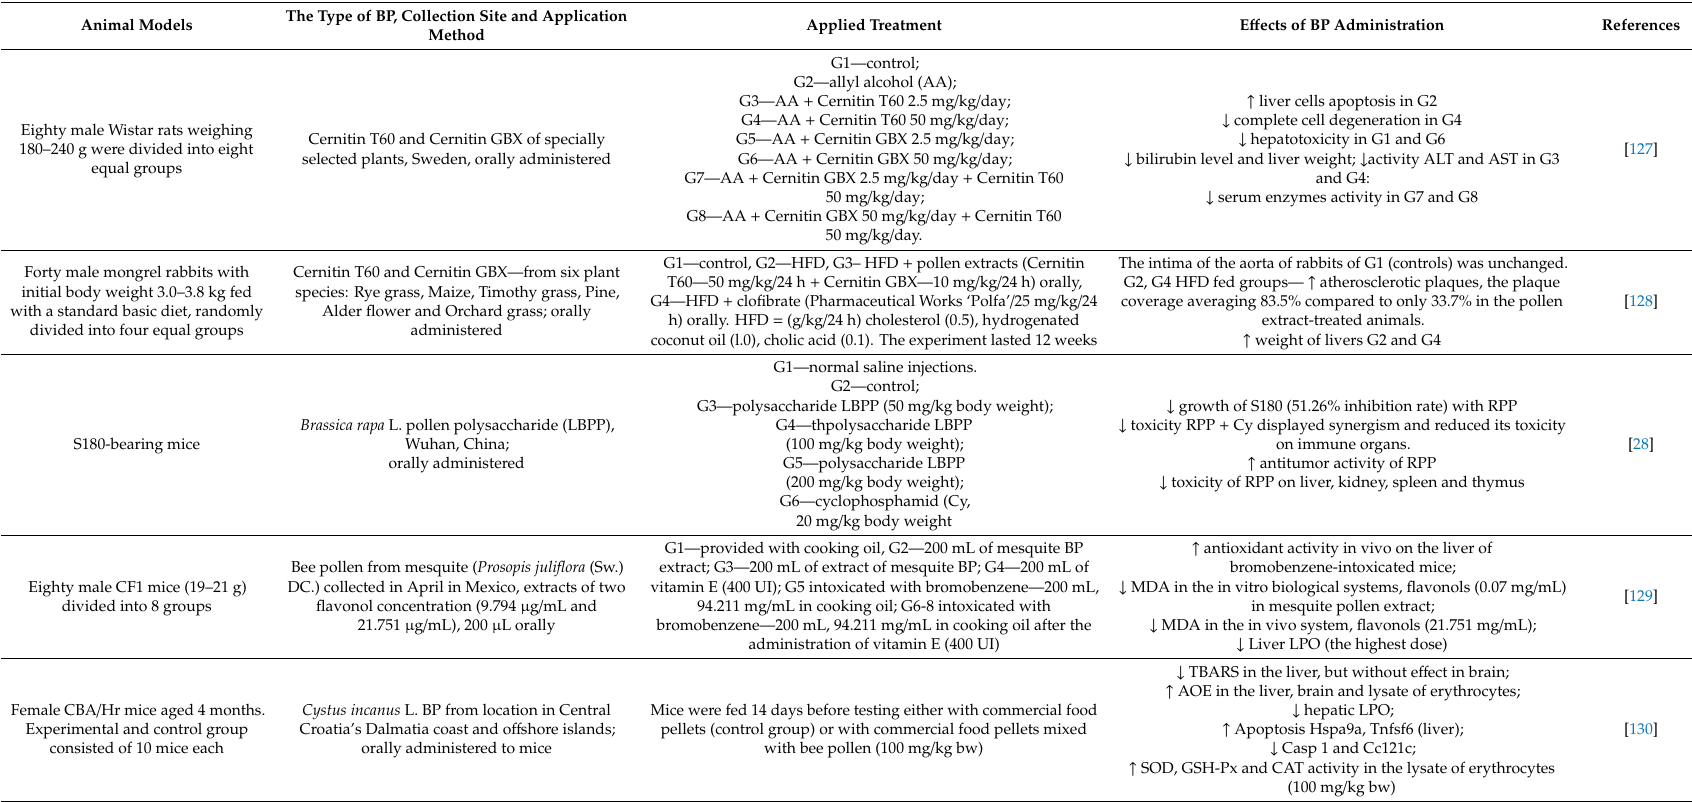
Table 4. In vivo studies regarding the e ff ect of BP in multiple diseases which imply liver